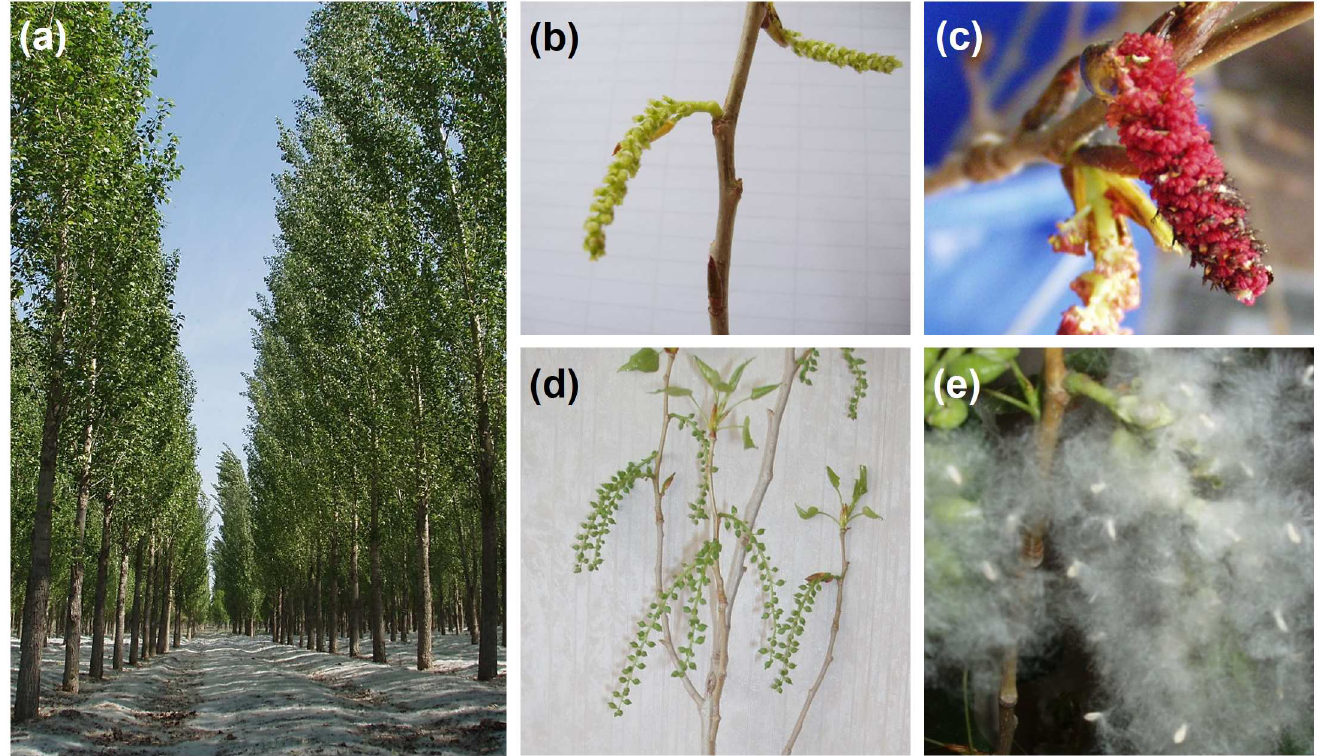
Fig 2. Female, male flowers, hybrid fruits and seeds of P . nigra cv. ‘ Pioneer’ and Bt P . nigra . (a) ‘Pioneer’plantation. (b) Female flowers of the ‘Pioneer’tree. (c) Male flowers of transgenic P . nigra (Cl. 222). (d) Fruits producedfrom a ‘Pioneer’female branchcrossed with pollenfrom Bt poplar. (e) Seeds of ‘Pioneer’pollinatedwith Bt